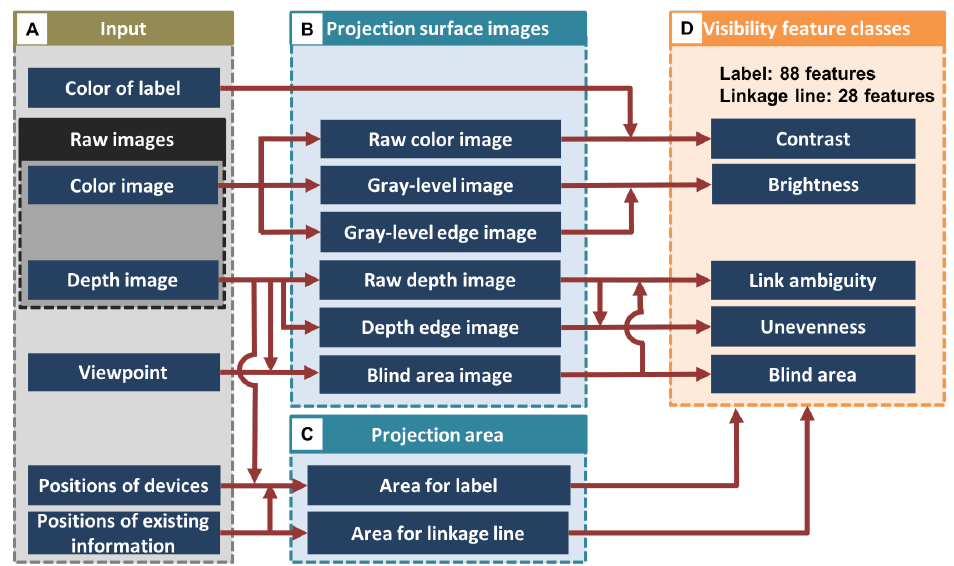
Figure 6. Processing flow in feature calculation.